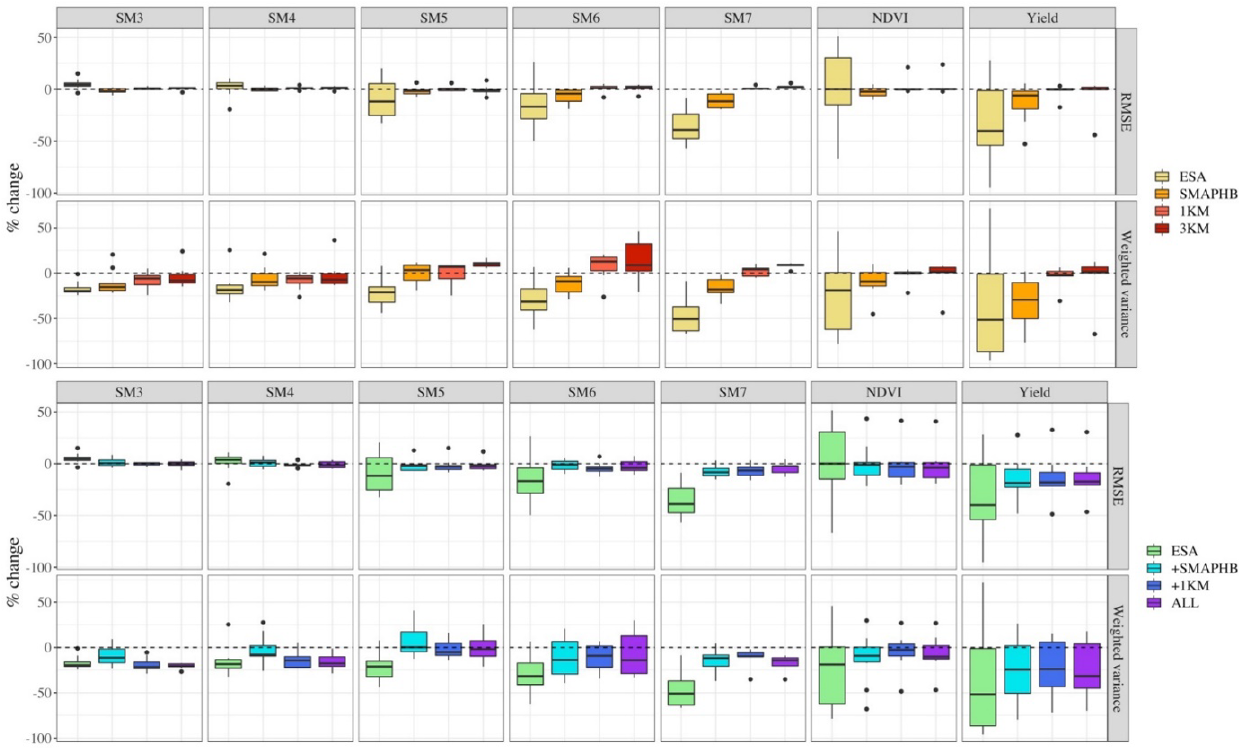
Figure 6. Boxplots demonstrating the distribution of relative change (%) in state variable accuracy (RMSE) and precision (weighted variance) for the (a) individual and (b) additive runs across all site years. Change is computed relative to the free model results. Negative values indicate improvement (e.g., ( RMSES − RMSEF )/